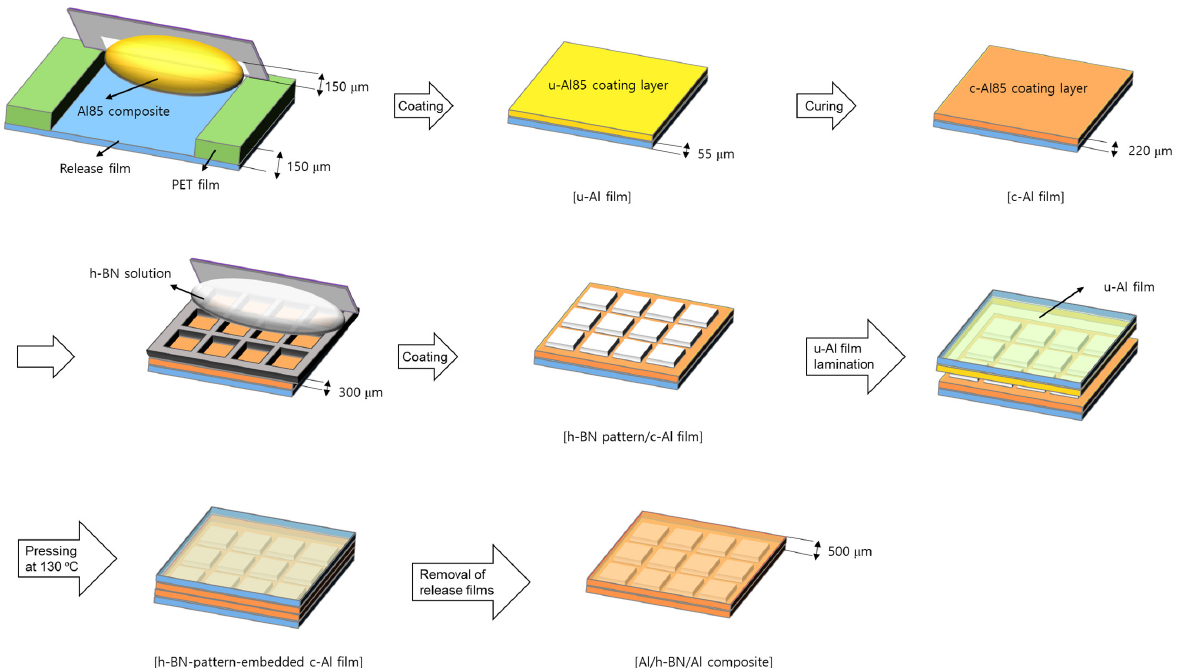
Figure 1. Schematic illustration of the fabrication process of Al/h-BN/Al composites.